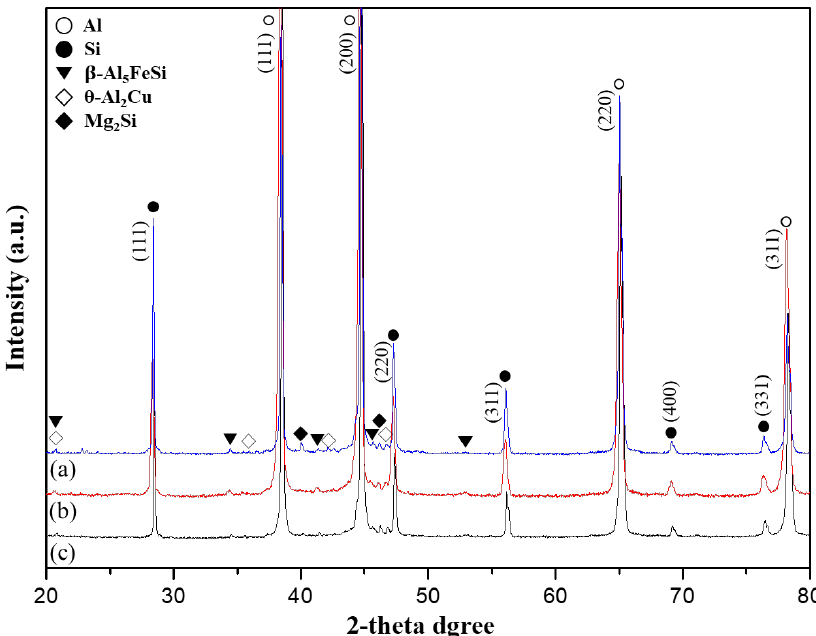
Figure 6. XRD patterns of Al-XSi-3Cu-0.6Mg-0.5Fe [X = ( a ): 10; ( b ): 12.6; ( c ): 14] extruded bars after T6 treatment.